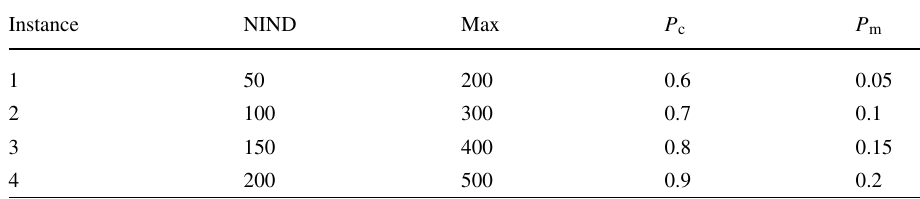
Table 2 Factors and their levels for GA-2HMS&TS Instance